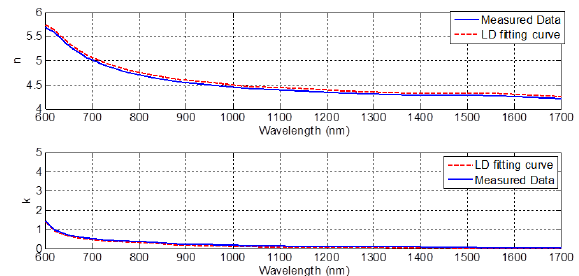
Figure 12. The mean error for the real and imaginary parts of Si permit- tivity through the entire wavelength of solar spectrum.